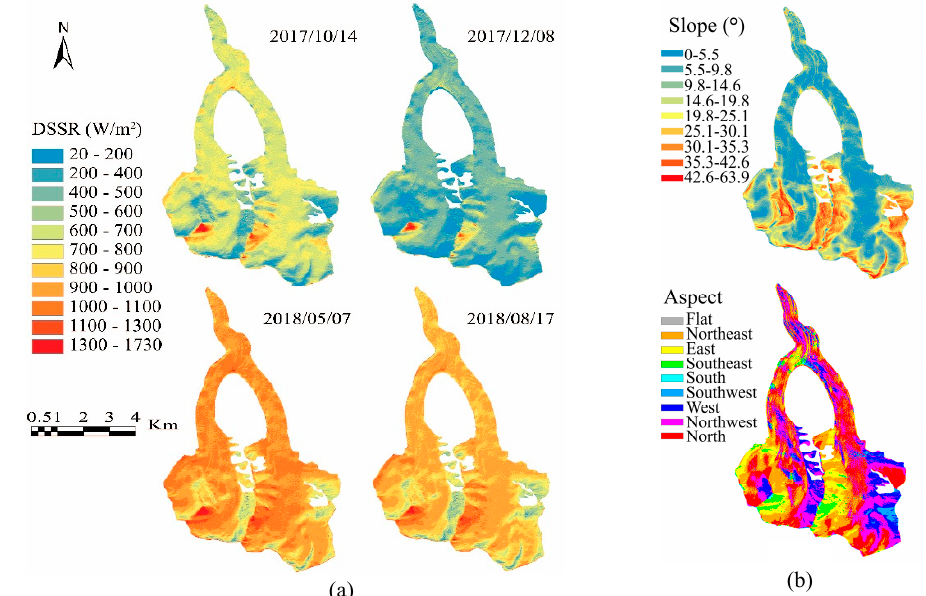
Figure 4. Spatial distribution characteristics of the S2 images and DSSR over four typical periods during a mass-balance year: ( a ) global solar radiation at the S2A/B overpass time and ( b ) maps of the slope and aspect. Table 3. Four typical S2 data points and statistical features of the estimated DSSR.